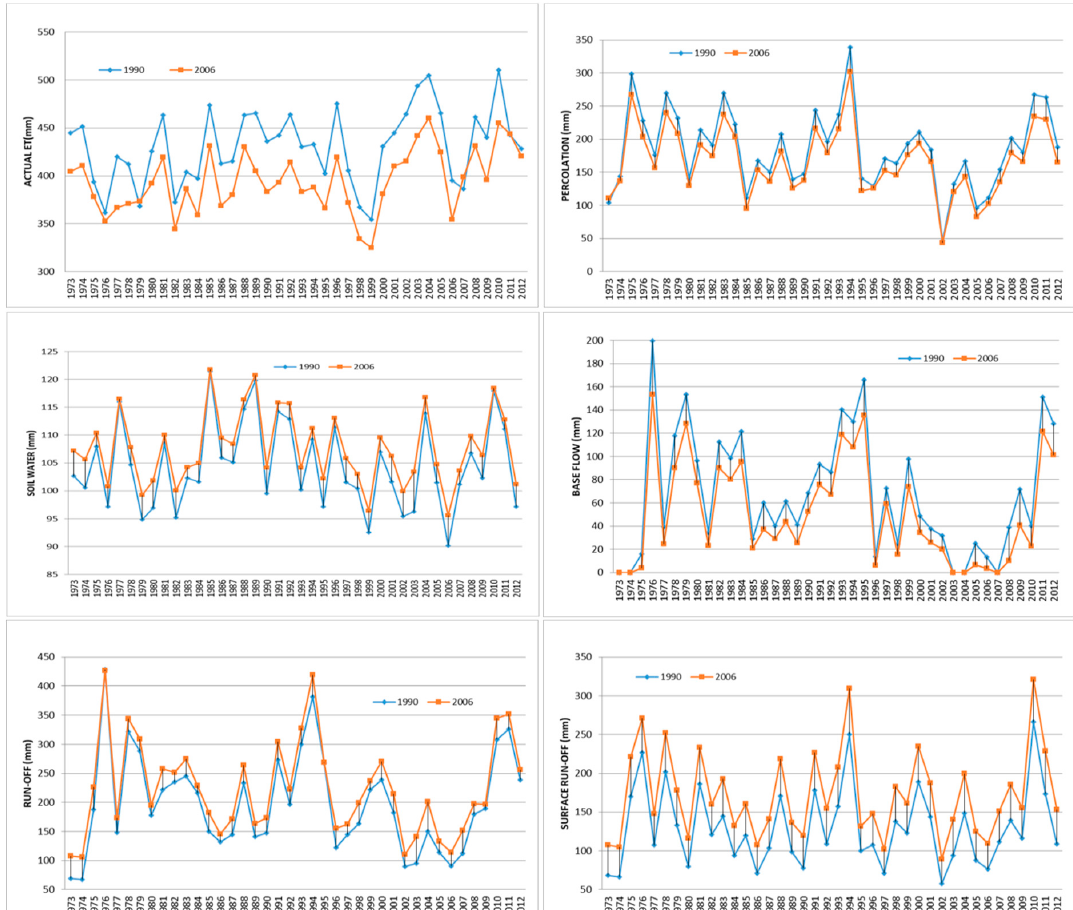
Figure 5. Annual average actual evapotranspiration, percolation, soil water, base flow, surface runoff and runoff time ‐ series with two different LC in the first sub ‐ basin.